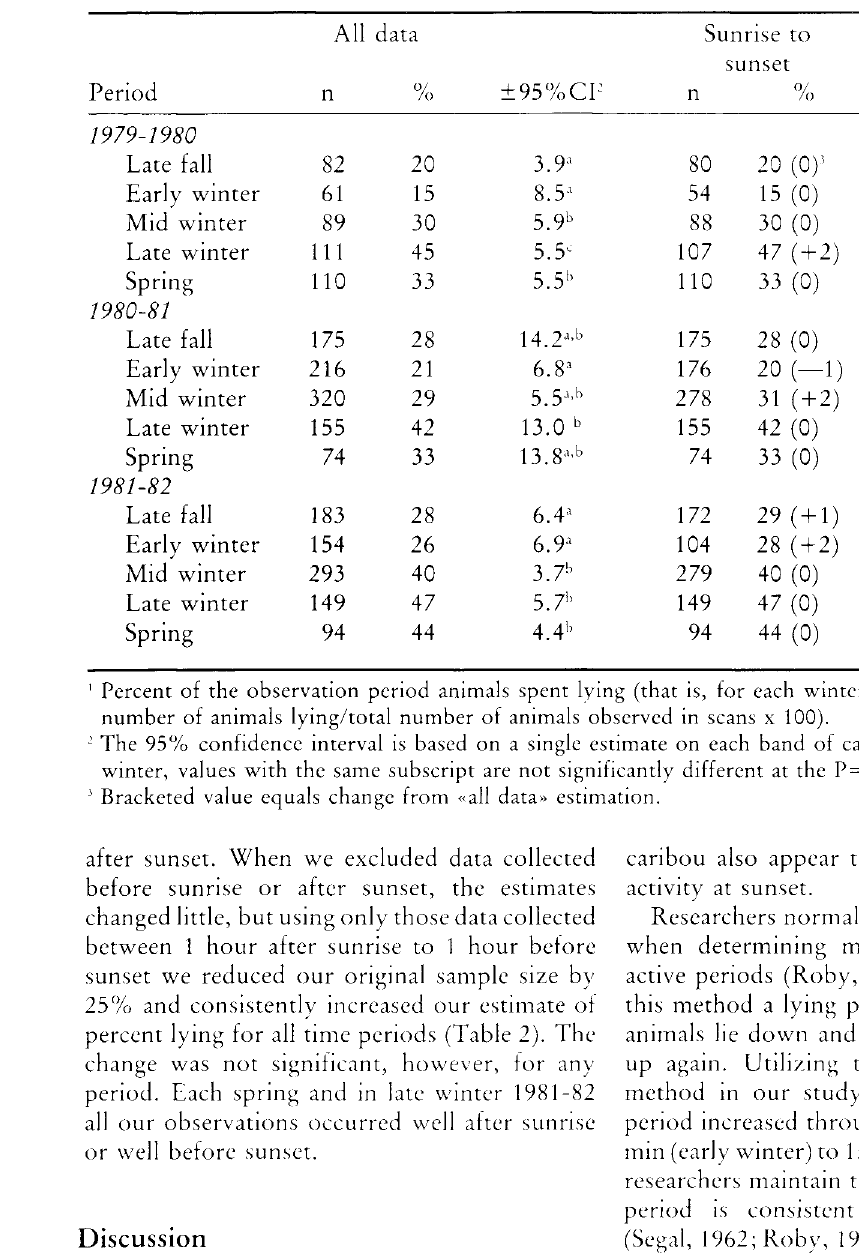
Table 2. Estimation of percent lying' from data of different time intervals (n=number of scans). All data Sunrise to Hour after sunrise to